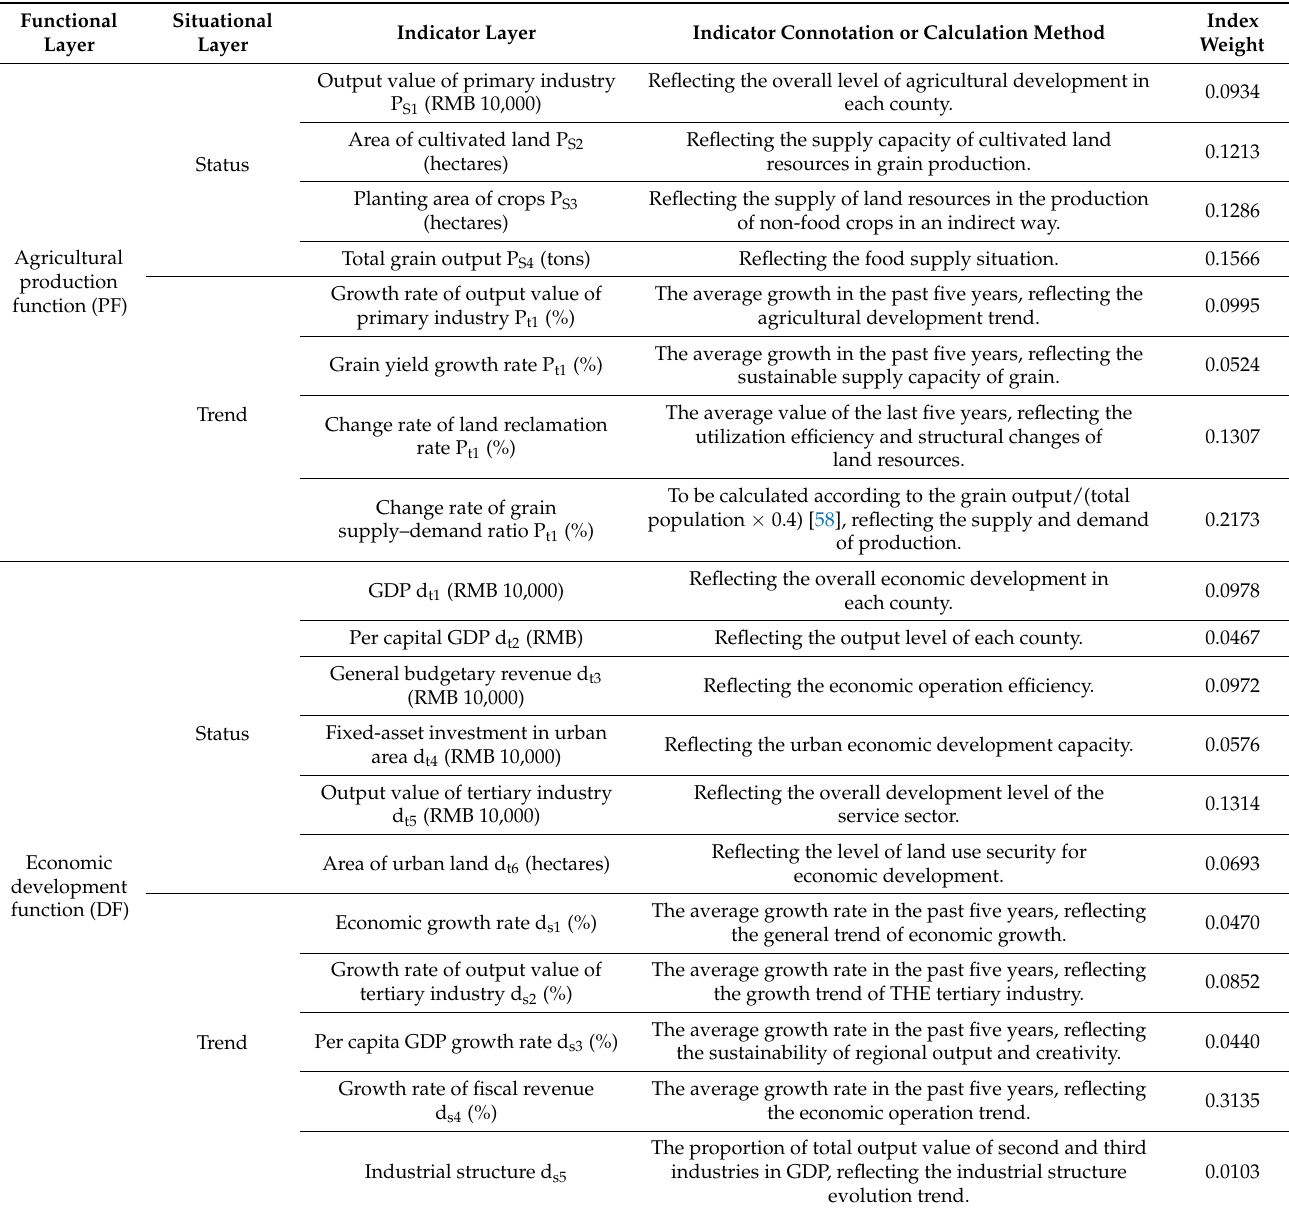
Table 1. Multi-functional evaluation indicator system and weight of